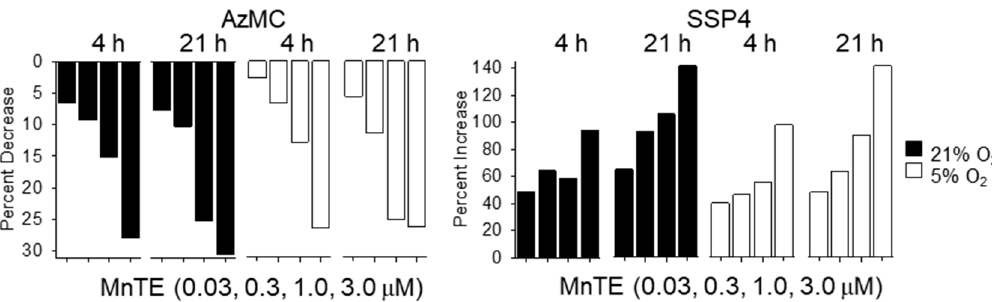
Figure 2. Concentration-dependent effects of MnTE on the percentage decrease in intracellular H 2 S and percentage increase in polysulfides (H 2 S n ) after 4 and 21 h in hyperoxia (21% O 2 ) or physioxia (5% O 2 ). Values derived from mean values of Figs.1 (3 μ M), S1 (0.3 μ M) and S2 (0.03 μ M) and 1.0 μ M (not shown). Decreases in H 2 S and increases in polysulfides are dependent on MnTE concentration.